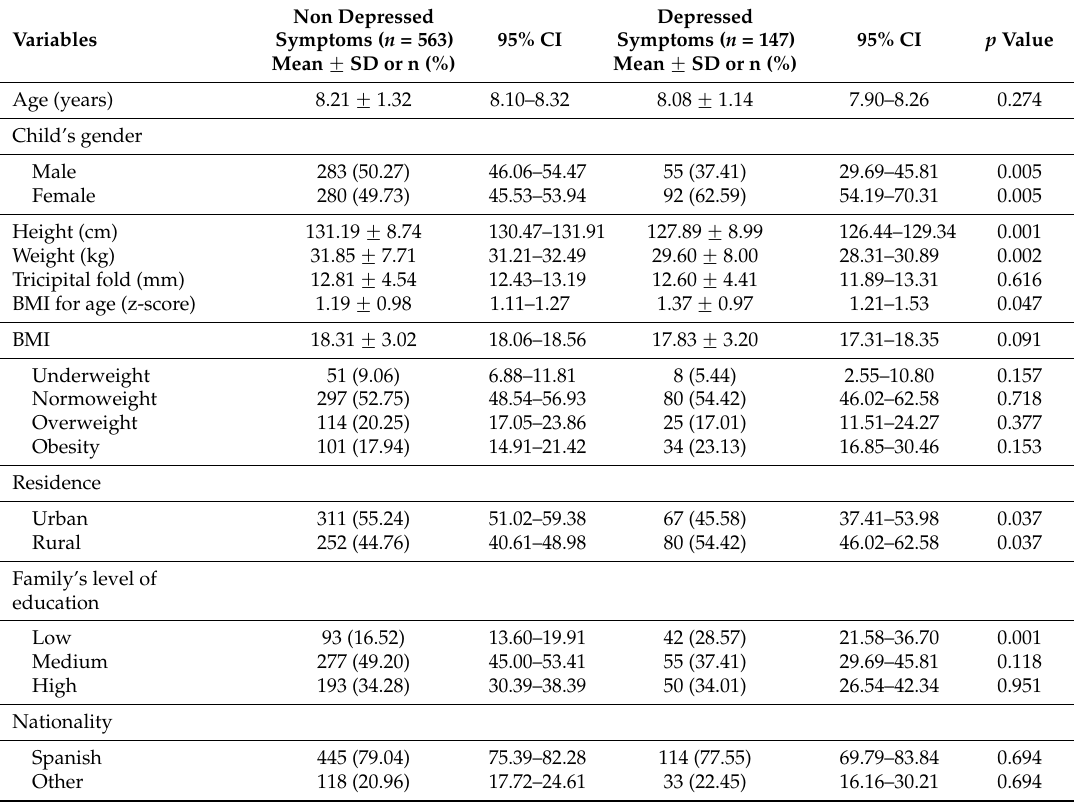
Table 1. Schoolchildren’s demographic characteristics based on the depressive symptoms